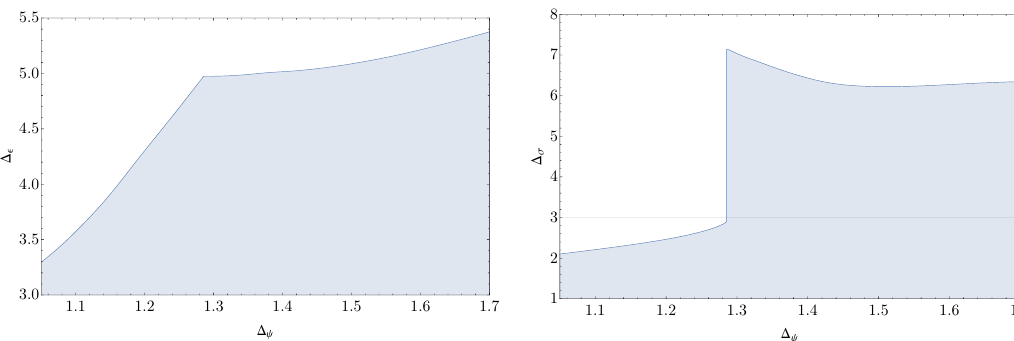
Figure 1 : Left: the bound on the gap ∆ bound on the gap ∆